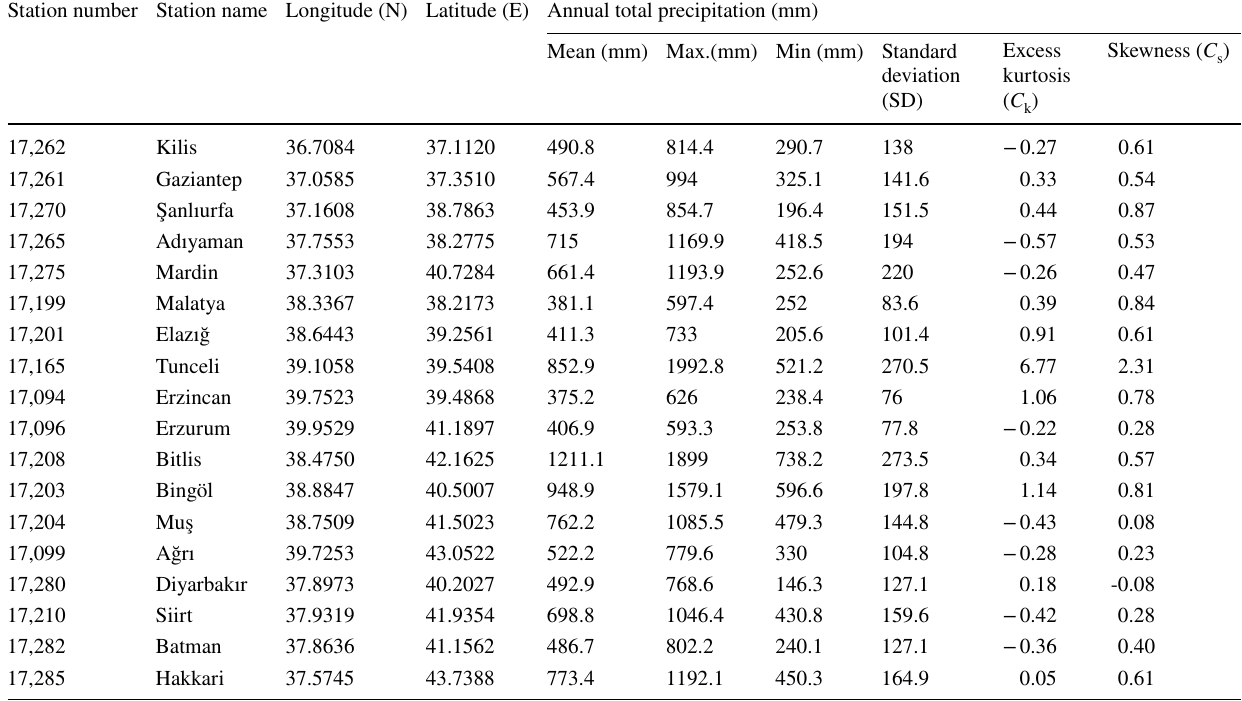
Table 1 Geographical features and annual precipitation characteristics of stations in ETRB Station number Station name Longitude (N) Latitude (E) Annual total precipitation